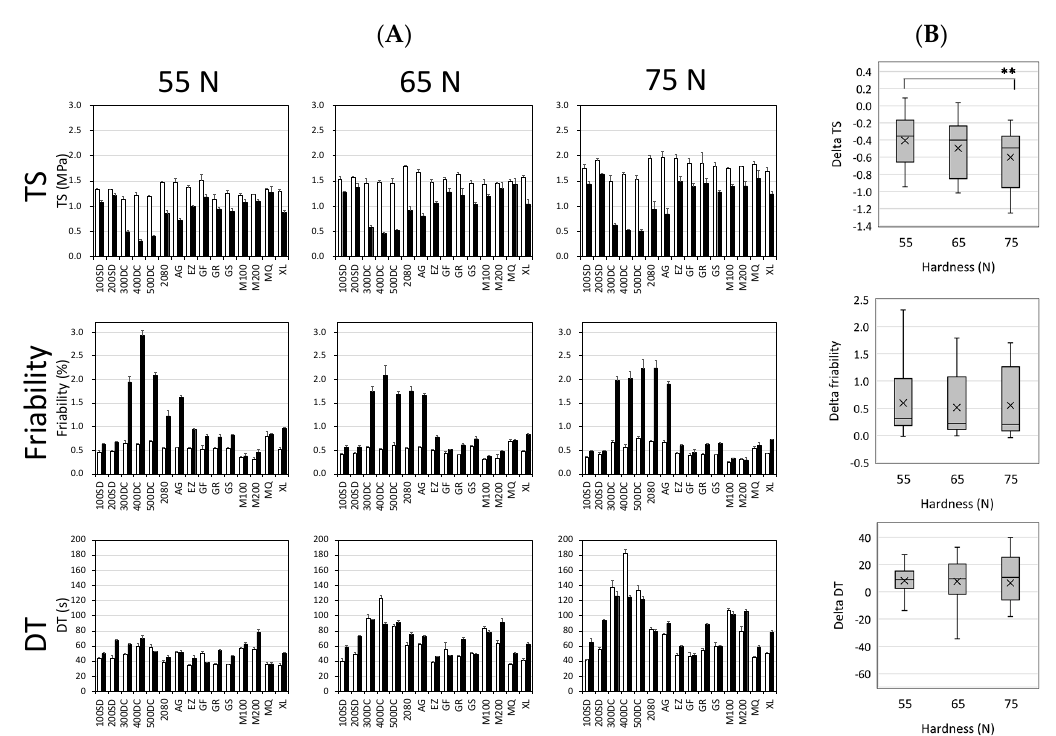
Figure 1. Tablet properties of pre- and post-storage tablets consisting of different mannitol grades. Model tablets having 55, 65, and 75 N of hardness were tested. ( A ) White and black bars represent the variables of pre- and post-storage tablets, respectively. Each bar represents the mean ± SD ( n = 3). ( B ) Box plots of the delta of variables between pre- and post-storage tablets. The lower and upper ends of the rectangular box represent the first and third quartiles of the variables, a horizontal line and “ × ” in the interior of the box express the median and mean, and the lower and upper ends of the whiskers indicate the minimum and maximum of the variables, respectively. ** p < 0.01.